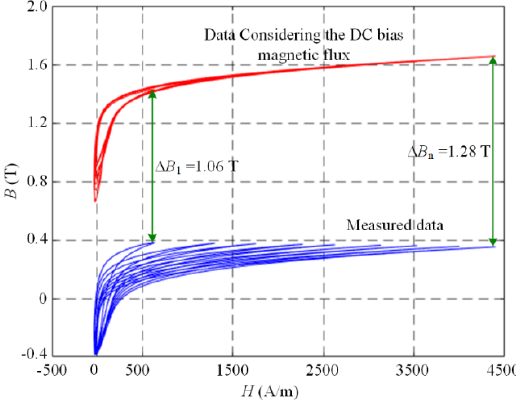
Figure 4. Core loss considering the dc magnetic bias.